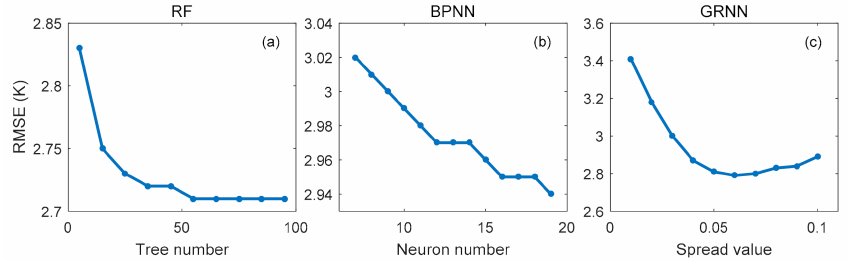
Figure 4. Root mean square errors versus ( a ) the number of trees, ( b ) the neuron number in the hidden layer, and ( c ) the spread value derived from the 10-fold cross-validation